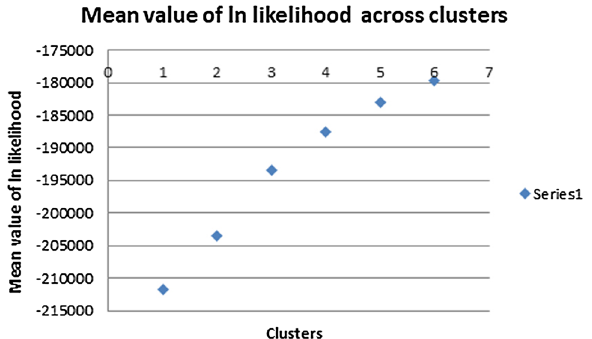
Figure 6. Graphical presentation of mean value of log likelihood across the inferred clusters.